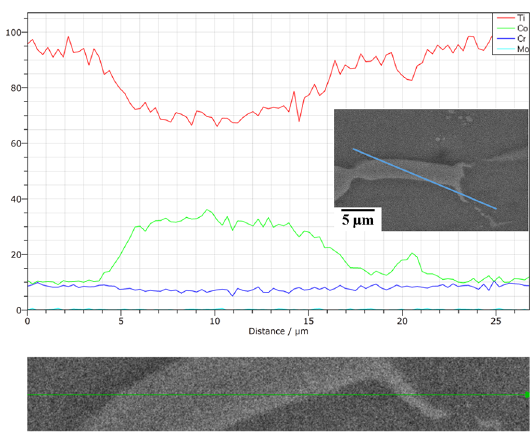
Figure 6. Line analysis across the eutectic phase for a sample sintered at 1130 °C.